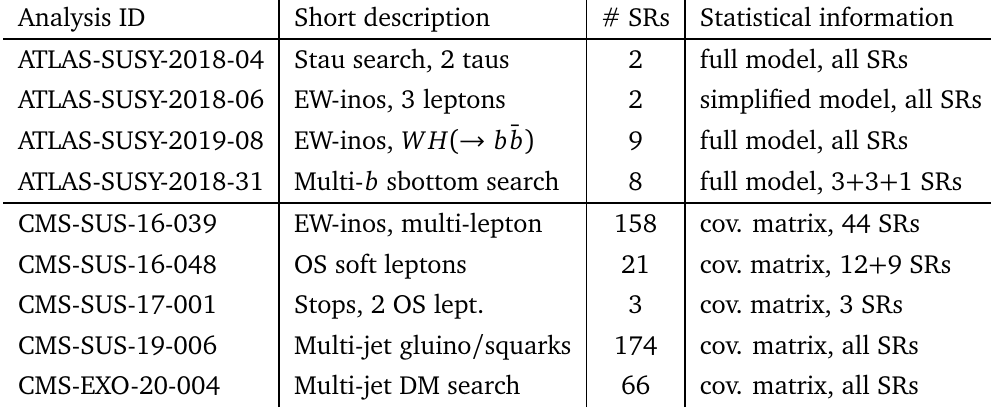
Table 1: Overview of M AD A NALYSIS 5 recast codes for which SR combination is avail- able. The last column specifies the statistical information used for the combination. Here, “full (simplified) model” stands full (simplified) JSON-serialised H IST F ACTORY model from ATLAS, to be used with P YHF , while “cov. matrix” stands for covariance matrix in the simplified likelihood approach of CMS. Details are given in section